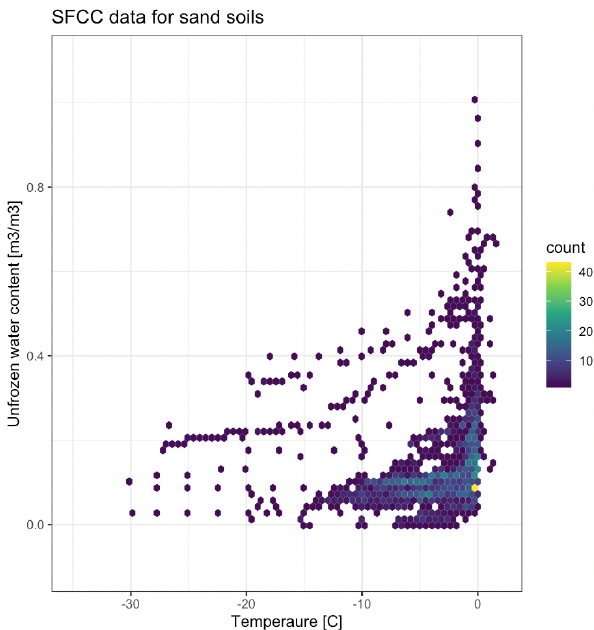
Figure 4. Example SFCC data pulled from a repository describing sandy soils. The colour of the grid cells represents data